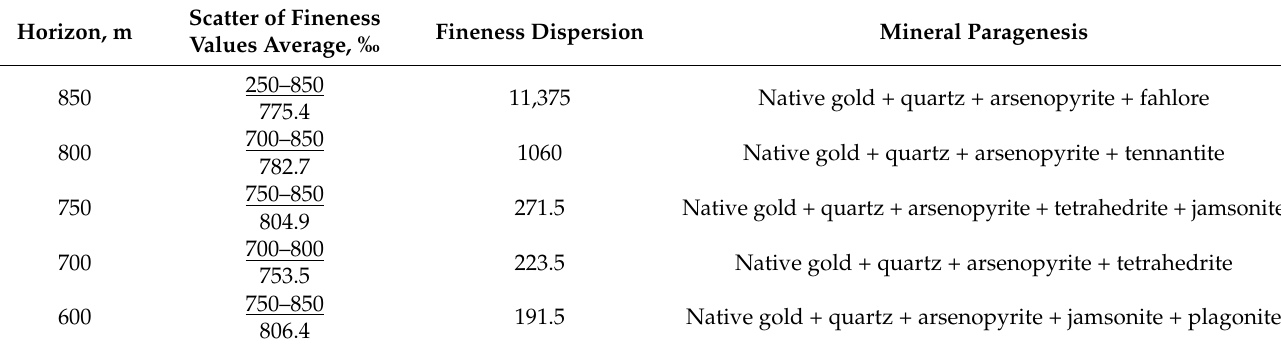
Table 3. Characteristics of native gold from ores of different horizons of the gold–quartz veins GIT Shkolnoye deposit.